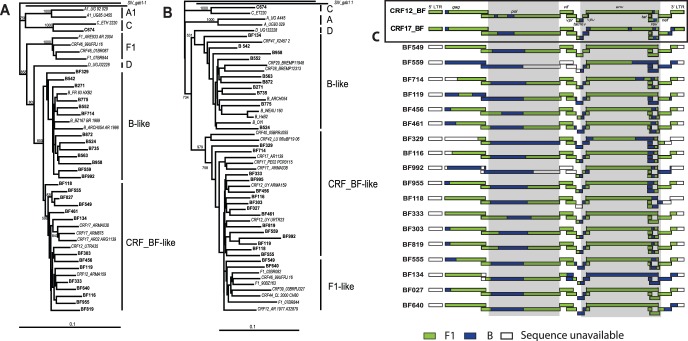
Genotypic Characterization of HIV-1 primary isolates from Argentina.Phylogenetic trees were constructed for (a) partial pol (2253–3749, HXB2) and (b) vpu to env (5968–9092, HXB2) of Argentinean primary isolates. Sequences were aligned using Clustal X and trees constructed by neighbor joining method under the Kimura 2-parameter model. (c) Sequences were aligned and bootscanned as described in materials and methods to determine recombination sites. Sequences in green represent the subtype F1 regions and in blue-subtype B. Regions in the genome that were not sequenced are represented by empty boxes. The gray shading represents those sequences used for the phylogenetic trees in 2a and b respectively.